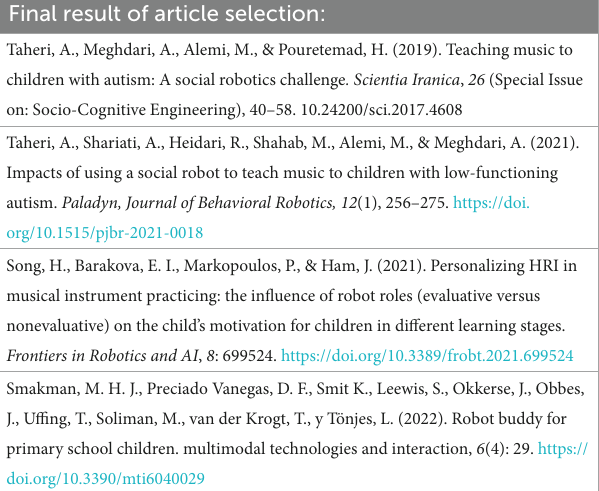
TABLE 3 Selected